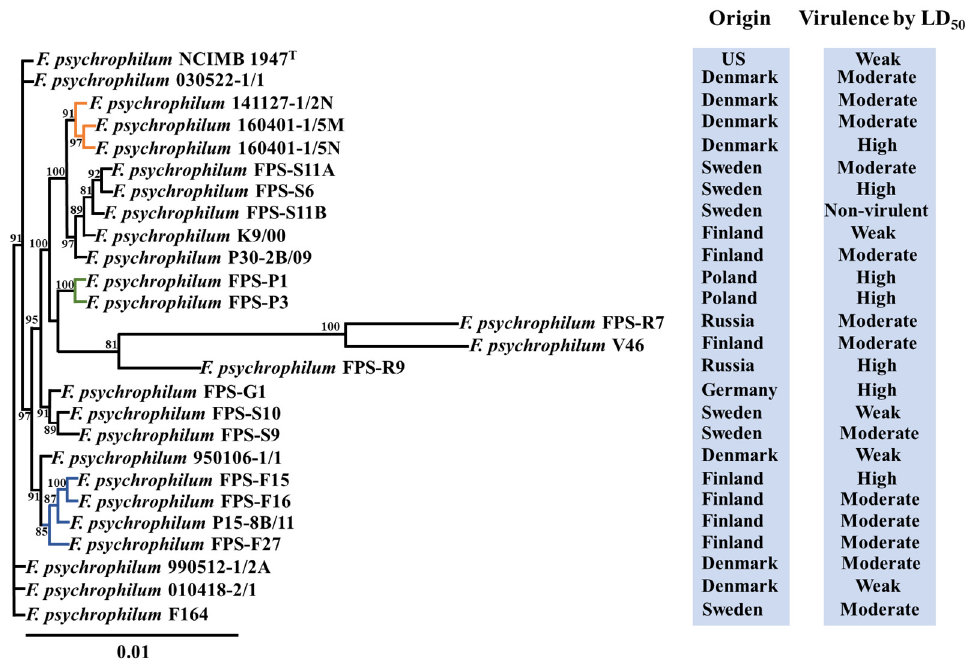
Figure 2. Core genome phylogeny of F. psychrophilum isolates . The maximum likelihood tree was ob- tained from a concatenated amino acid sequence alignment of the orthologous core genes (1866 ORFs) for the twenty-five F. psychrophilum isolates and the type strain NCIMB 1947 T . The numbers above the branches indicate the bootstrap value. Bootstrap values of <80% were removed from the tree. The horizontal bar at the base of the figure represents 0.01 substitution per amino acid site. The virulence properties of the isolates and geographical places of origin were added to facilitate